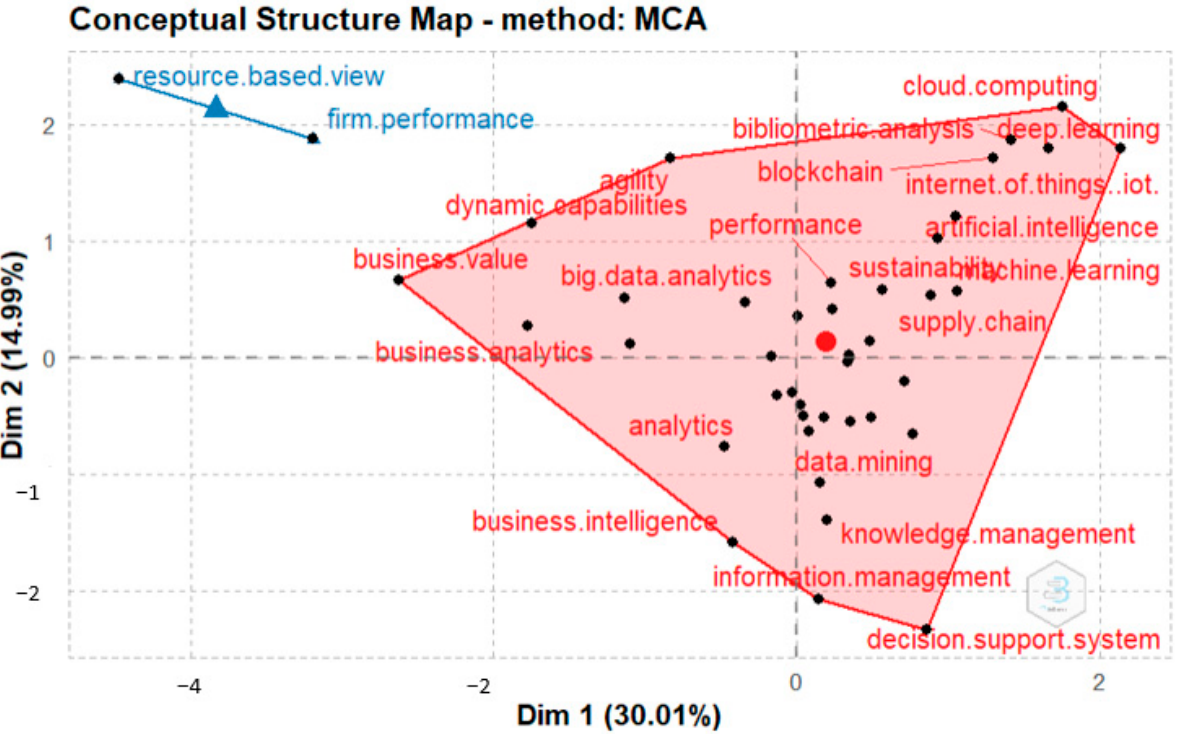
Figure 13. Factorial analysis based on the MCA method.